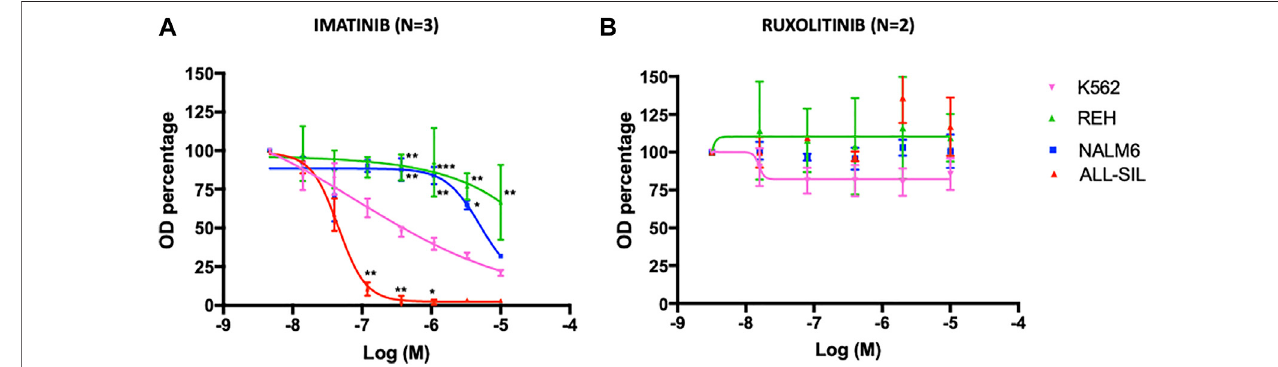
FIGURE 4 | Dose-response curve with (A) imatinib and (B) ruxolitinib. Leukemia cell lines were seeded at 12,000 cells/well with a range of concentrations of 0.014 – 10 µM forimatinib and 0.016 – 10 µM forruxolitinib. MTTassay wasperformed after 72 h ofincubation. Error bars represent mean ± SEM( n (cid:2) 3for imatinib, n (cid:2) 2 for ruxolitinib). REH, NALM6 or ALL-SIL versus K562: * p < 0.05; ** p < 0.001, *** p < 0.0001 two-way ANOVA, Bonferroni post-test.